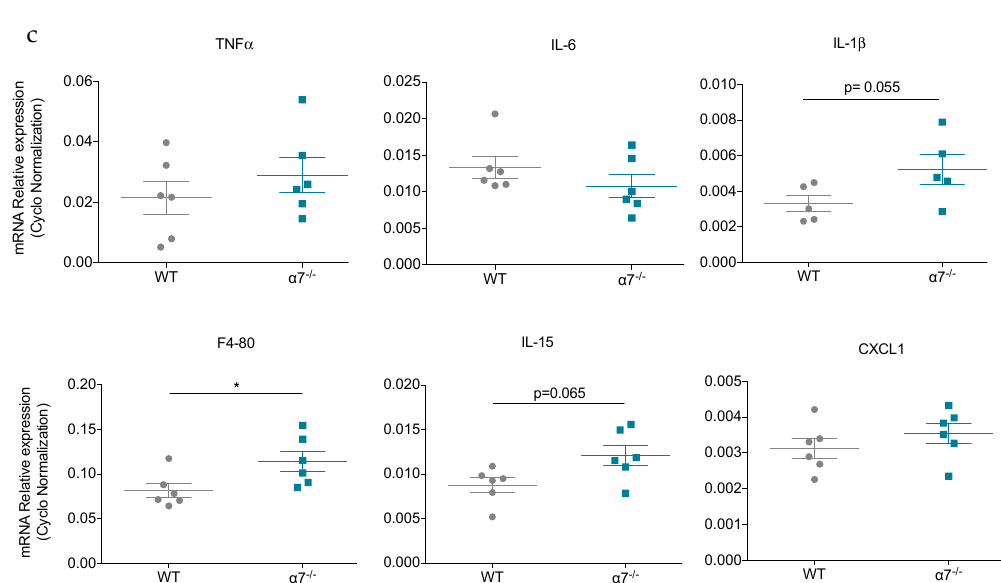
Figure 7. Twenty-five-week-old α 7 − / − mice develop adipose inflammation. mRNA expression of characteristic pro-inflammatory marker TNF α , IL-6, IL-1 β F4/80, cytokine IL-15 and chemokines CXCL1